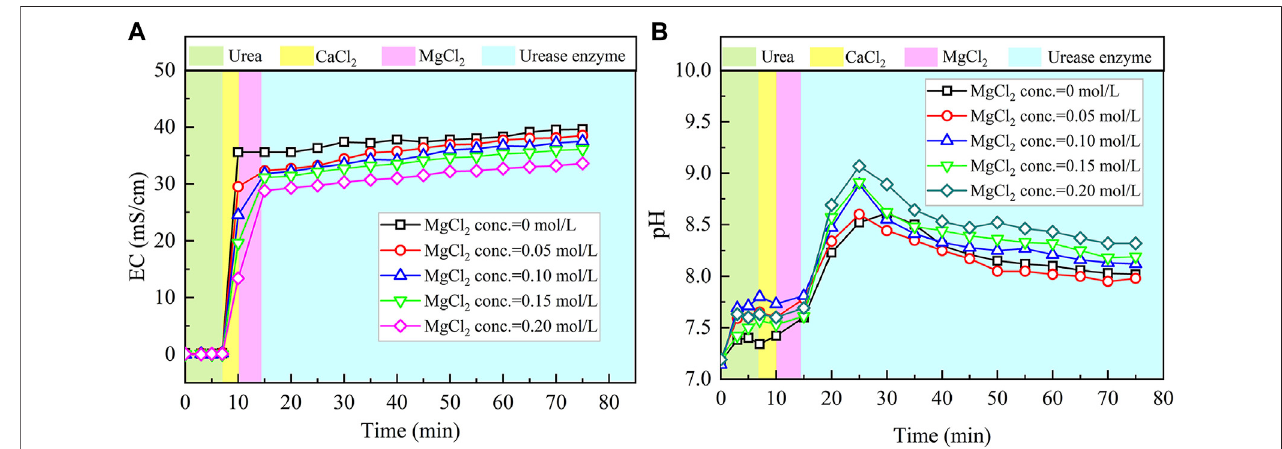
FIGURE 4 | Temporal relations of EC and pH when subjected to the effect of MgCl 2 addition: (A) EC and (B) pH.